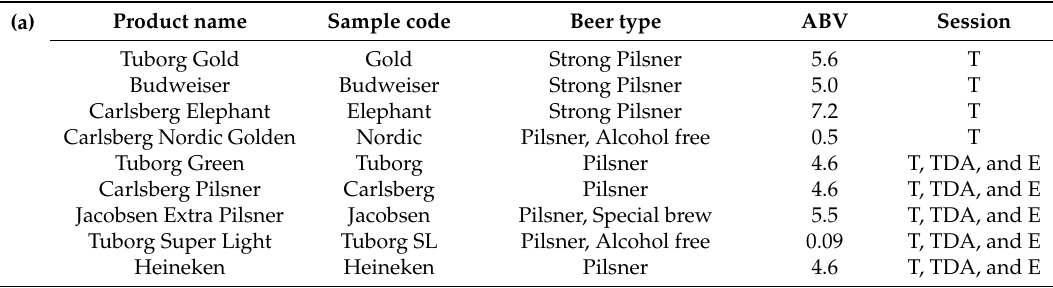
Table 1. ( a ) Samples used in the study for training (T), training descriptive analysis sessions during the training period (TDA), and DA evaluation sessions (E). ABV = ethanol content (% v / v ). ( b ) List of sensory attributes and reference beers used to establish minimum and maximum attribute